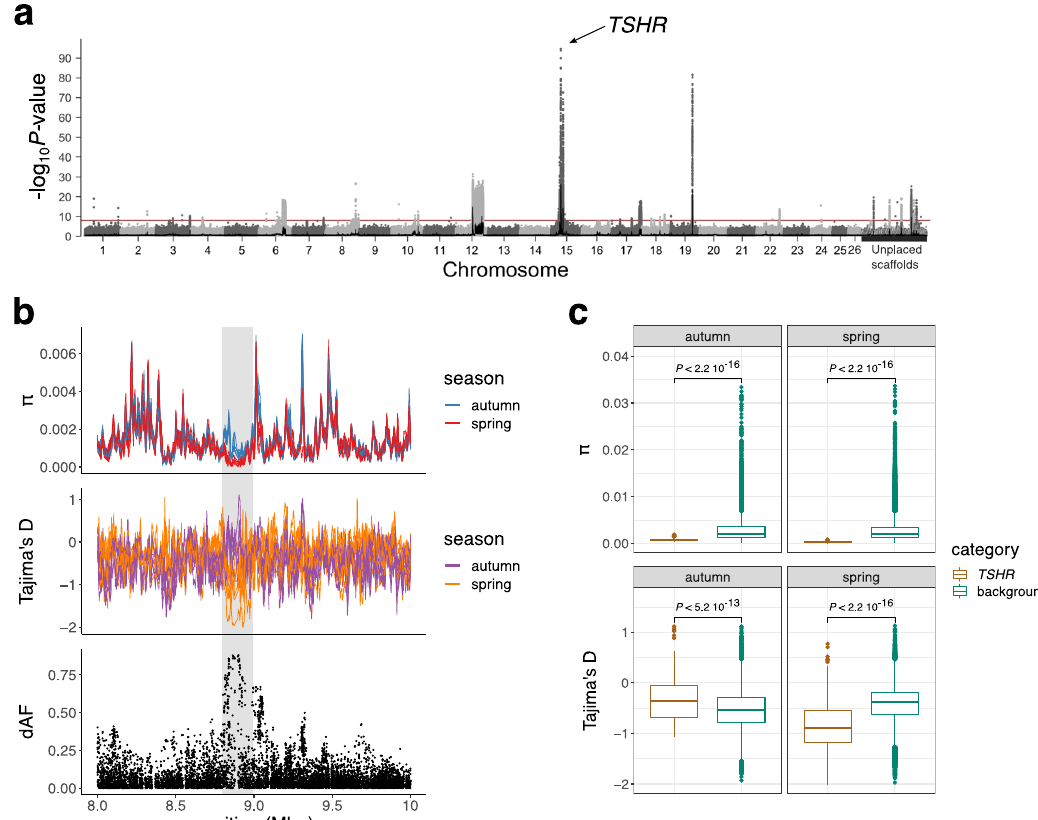
Fig. 1 Genetic diversity across the TSHR region in spring- and autumn-spawning Atlantic herring. a Genome scan based on 6.06 million SNPs for the identi fi cation of divergent genomic regions between seven spring- and seven autumn-spawning populations (based on data from Han et al. 16 ). The y-axis represents the signi fi cance value (-log 10 P -value) per SNP in a X 2 test comparing the allele frequencies in spring- and autumn-spawning populations. Each dot corresponds to a single SNP, and different shades of gray were used to distinguish SNPs in consecutive chromosomes. The horizontal red line indicates the signi fi cance threshold based on Bonferroni correction. b Genome-wide diversity statistics π and Tajima ’ s D, and absolute allele frequency differences (dAF) of seven spring- and seven autumn-spawning herring pools in chr 15: 8 – 10 Mbp. The location of TSHR is denoted with a shadowed gray area (chr 15: 8.85 – 8.95 Mbp). Each line corresponds to a single pool, and the two colors distinguish autumn- and spring-spawning populations. c Comparison of the π and Tajima ’ s D distributions between SNPs on chromosome 15 located outside (214 635 SNPs) and inside (8.85 – 8.95 Mbp, 215 SNPs) the TSHR region. The P -values were obtained from the Wilcoxon test applied to estimate the statistical signi fi cance of the mean differences between SNPs inside and outside the TSHR region for the spring- and autumn-spawning